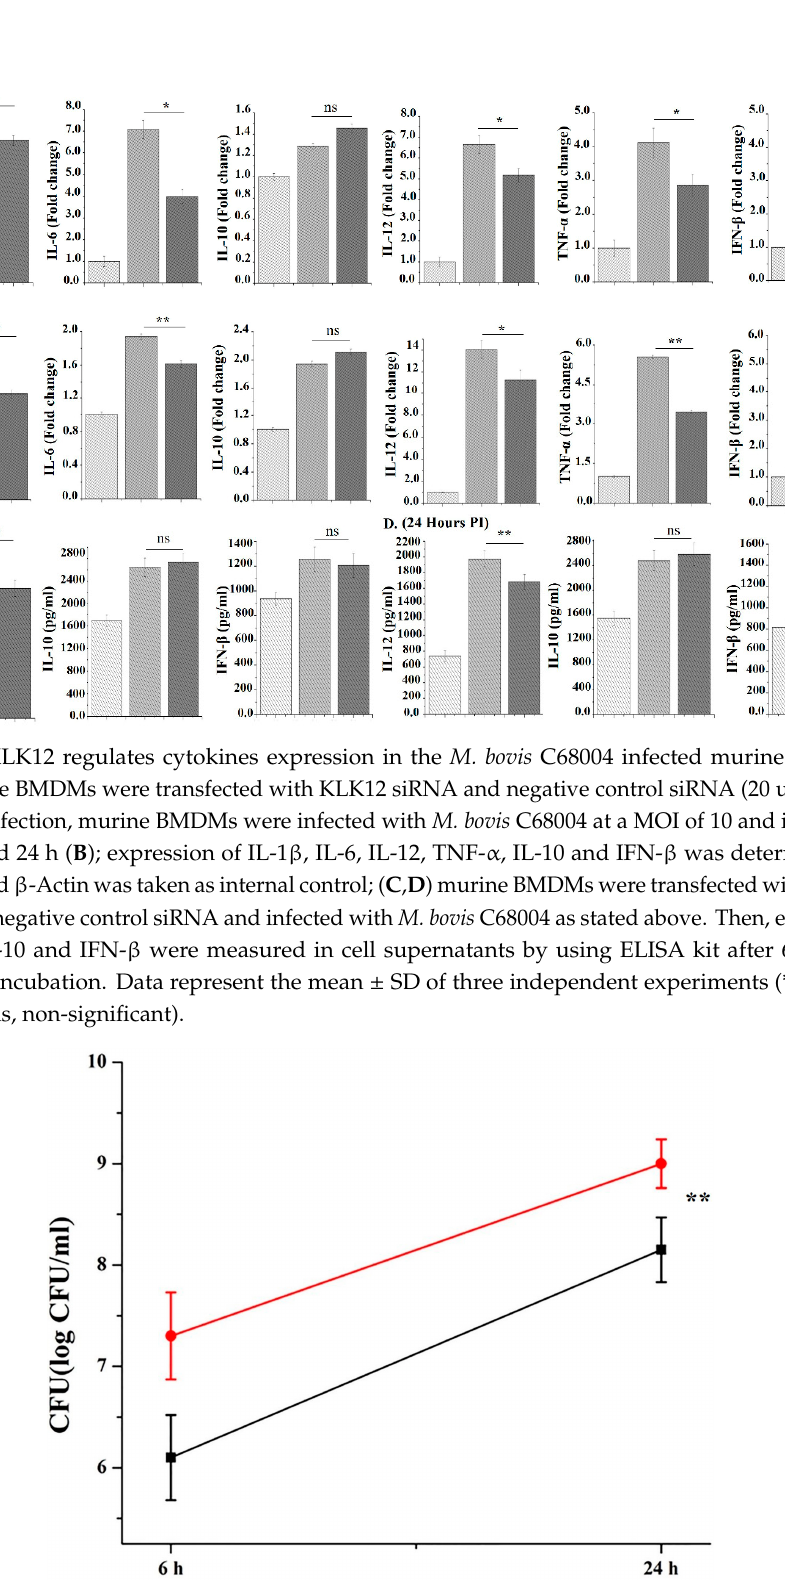
Figure 7. KLK12 restrains intracellular survival of M. bovis in murine BMDMs. Murine BMDMs were transfected with KLK12 siRNA and negative control siRNA (20 μ M). After 48 h of transfection, the were transfected with KLK12 siRNA and negative control siRNA (20 µ M). After 48 h of transfection, the BMDMs were infected with M. bovis C68004 at a MOI of 10 and incubated for indicated times (6 and 24 h) and bacterial survival was measured by the CFU assay. Data represent the mean ± SD of three independent experiments (** p <